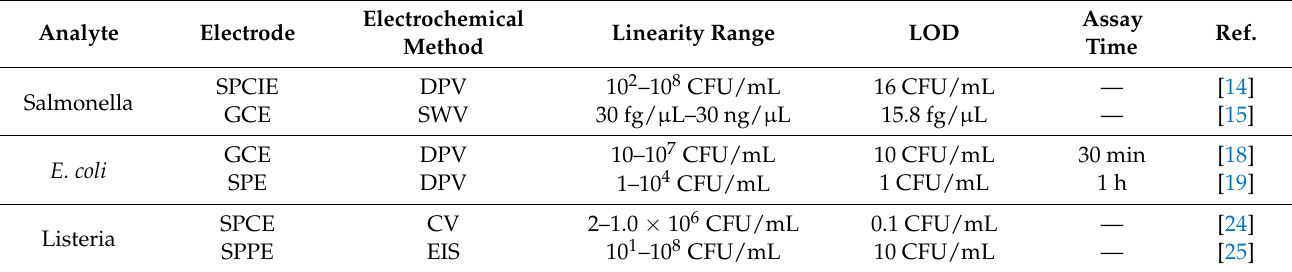
Table 1. Electrochemical biosensors for bacterial